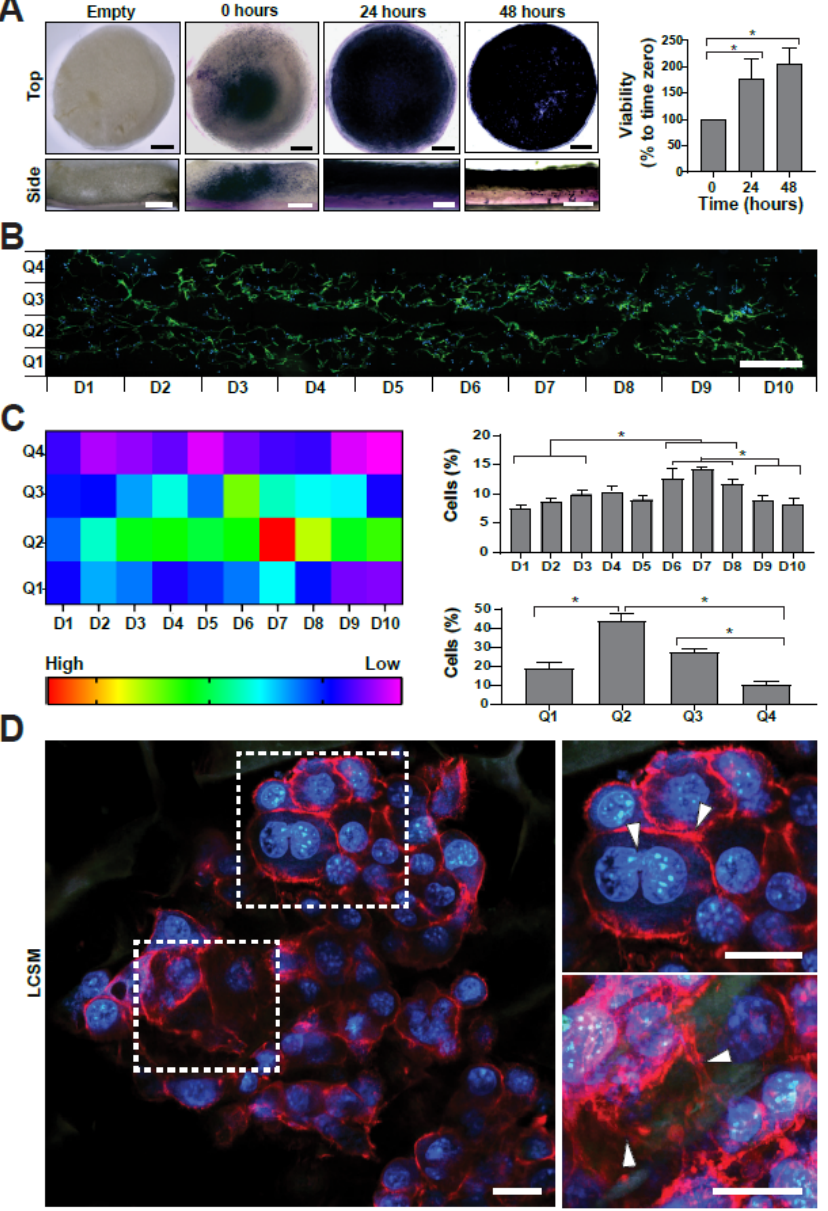
Figure 5. Establishment of a 3D tumor model. C32 cells were seeded in a collagen-GAG scaffold; 48 h post seeding, a significant increase in metabolic activity was quantified by MTT assays ( A ). 3D tumor model was cut into 5 µm slides and cell distribution was visualized by fluorescence microscopy ( B ). A heatmap ( C , upper left ) shows the cell distribution in the scaffold, showing a non-homogeneous internal distribution. Detailed analysis of the sections ( C , right ) shows that cells concentrate in the central sections of the scaffold. LCSM analysis of the seeded scaffolds shows tumor-like structures ( D , left ). Arrowheads in the magnified areas show cell–cell interactions and cell proliferation ( D , upper right ) and cell–matrix interactions ( D , lower right ). All assays were performed in at least three independent experiments and data are presented as average + SE. Scale bars represent 1 mm in ( A , B ) and 25 µ m in ( D ). p ≤ 0.05 was considered as significant using a one-way ANOVA test. * = p ≤